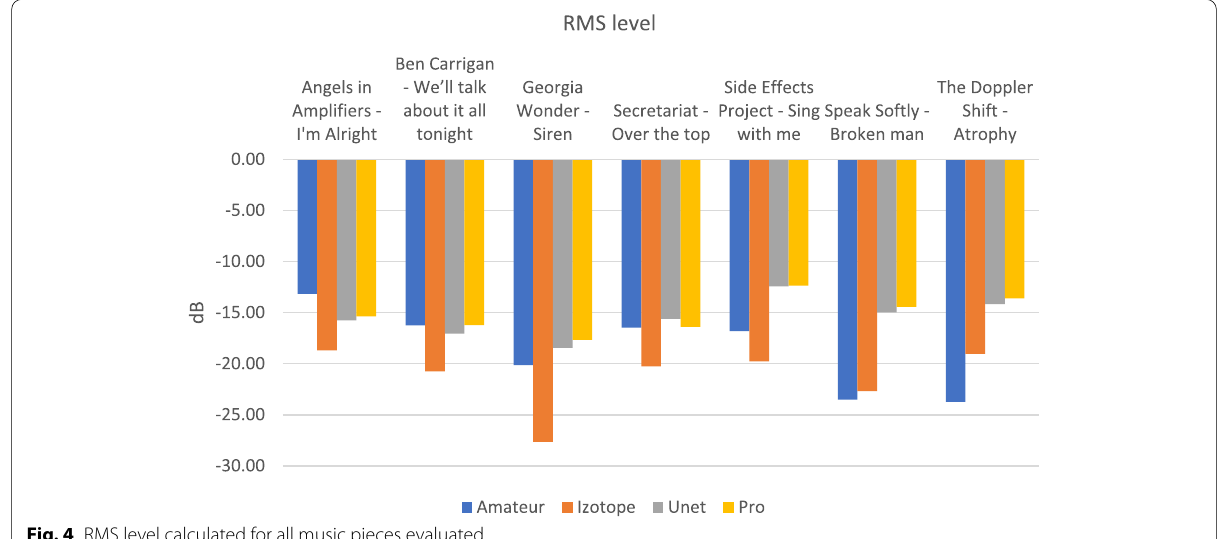
Fig. 4 RMS level calculated for all music pieces evaluated